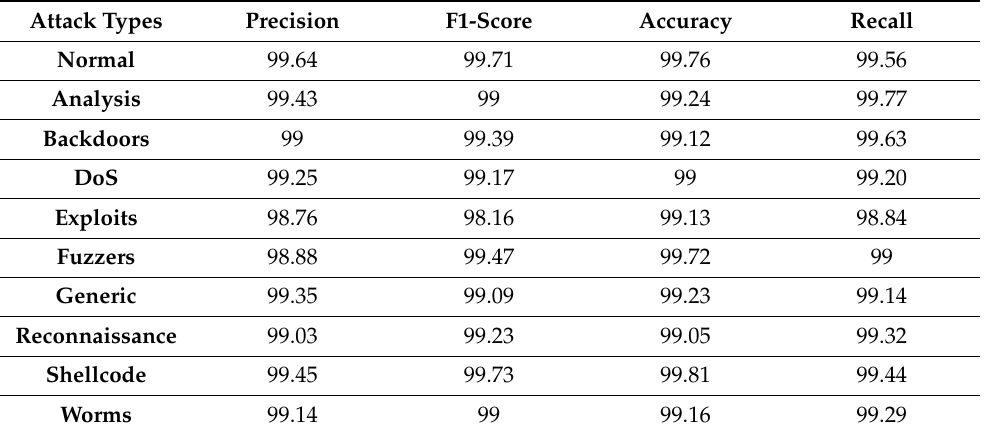
Table 8. Multi-class classification of the proposed approach on the UNSW-NB15